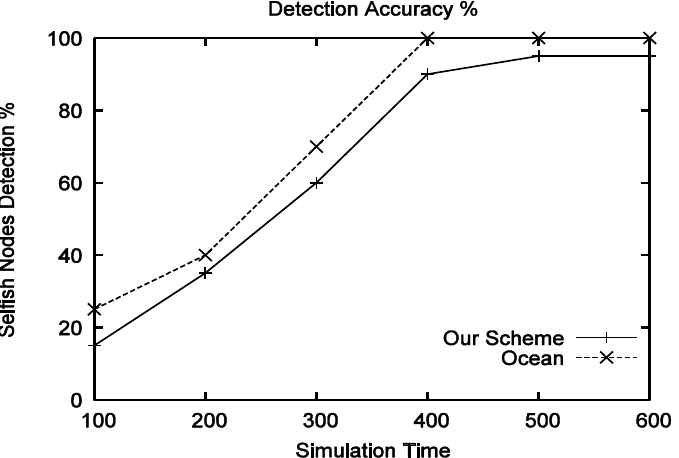
Figure 9. Performance comparison of the proposed scheme and OCEAN in terms of detection accuracy in the presence of type-II attackers. accuracy in the presence of type-II